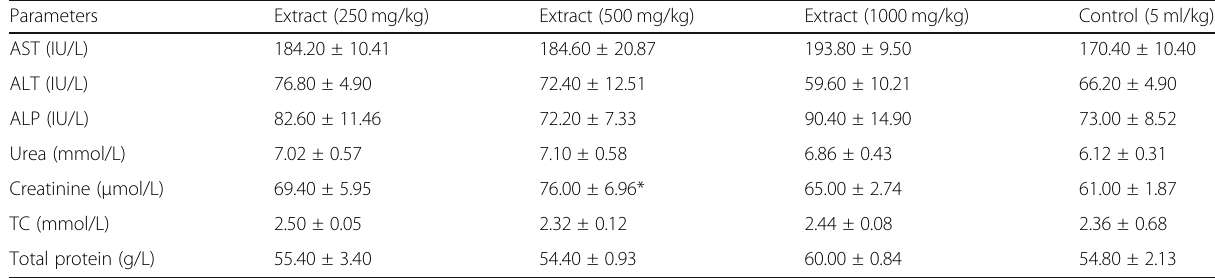
Table 5 Effects of ethanol fruit extract of H. madagascariensis on biochemical parameters in Wistar rats (Mean ± S.E.M). The extract produced no statistically significant ( P > 0.05) difference in the levels of aspartate aminotransferase (AST), alanine aminotransferase (ALT) and alkaline phosphate (ALP) in the extract treated groups when compared to the control. Meanwhile, there was a statistically significant ( P < 0.01) difference in the creatinine level of the 500 mg/kg extract treated group and the control. There was no statistically significant ( P > 0.05) difference in the level of blood urea and total cholesterol between the treated groups and the control. However, there was a marginal increase which is not statistically significant ( P > 0.05) in the total protein level of the group administered with 1000 mg/kg of extract and the